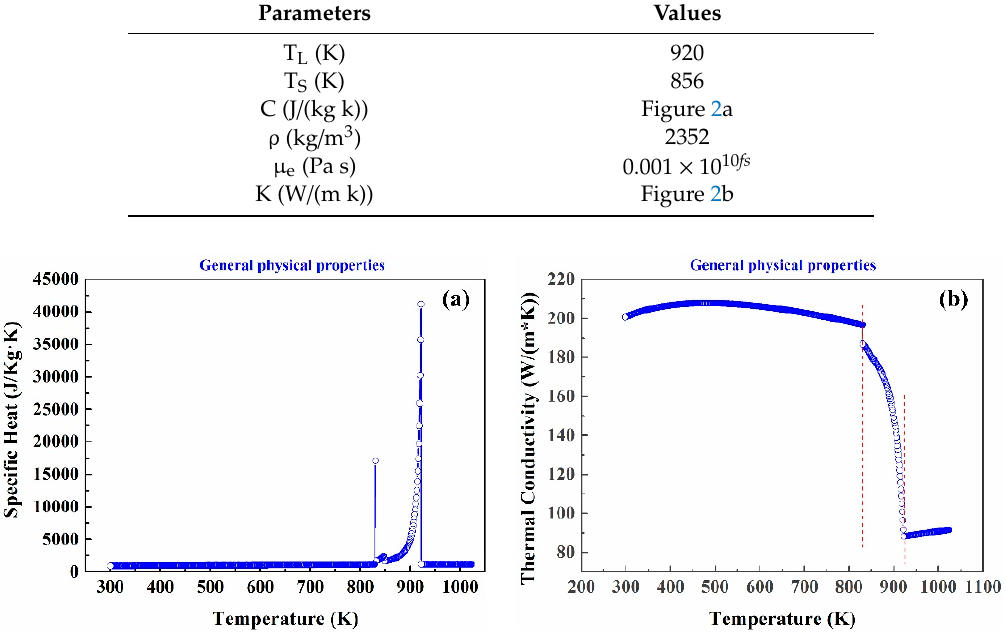
Table 1. Thermal physical properties of AA6022 aluminum alloy. Parameters